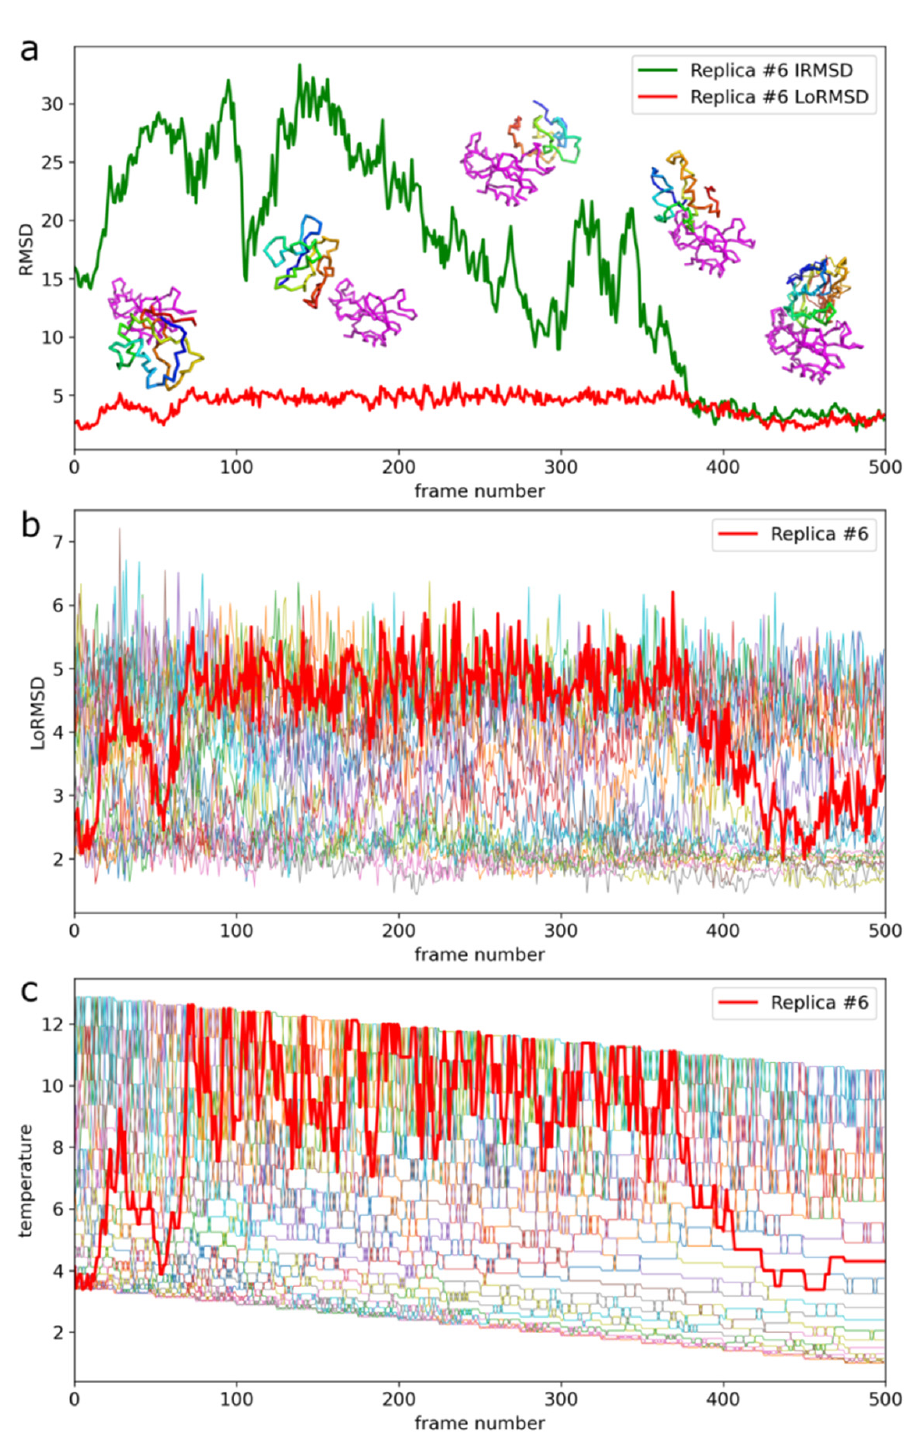
Figure 3. Docking trajectory for the selected replica of barnase/barstar system. The presented replica reached the most accurate barnase/barstar complex structure. ( a ) iRMSD (interface RMSD) and LoRMSD (ligand only RMSD) values. Example simulation snapshots illustrate the plot. The ligand is presented in rainbow colors, the receptor in magenta. The lowest iRMSD model (1.9 A from X-ray structure) is presented on the right lower corner superimposed on the X-ray structure (the X-ray structure is shown in thick lines, the predicted model in thin lines). ( b ) Ligand only RMSD (LoRMSD) values for all replicas. The thick red line presents selected replica. ( c ) Exchange of system replicas between different temperatures driven by Replica Exchange Monte Carlo (REMC) system. The thick red line presents selected replica. The replica trajectory is also presented in the Video S1.